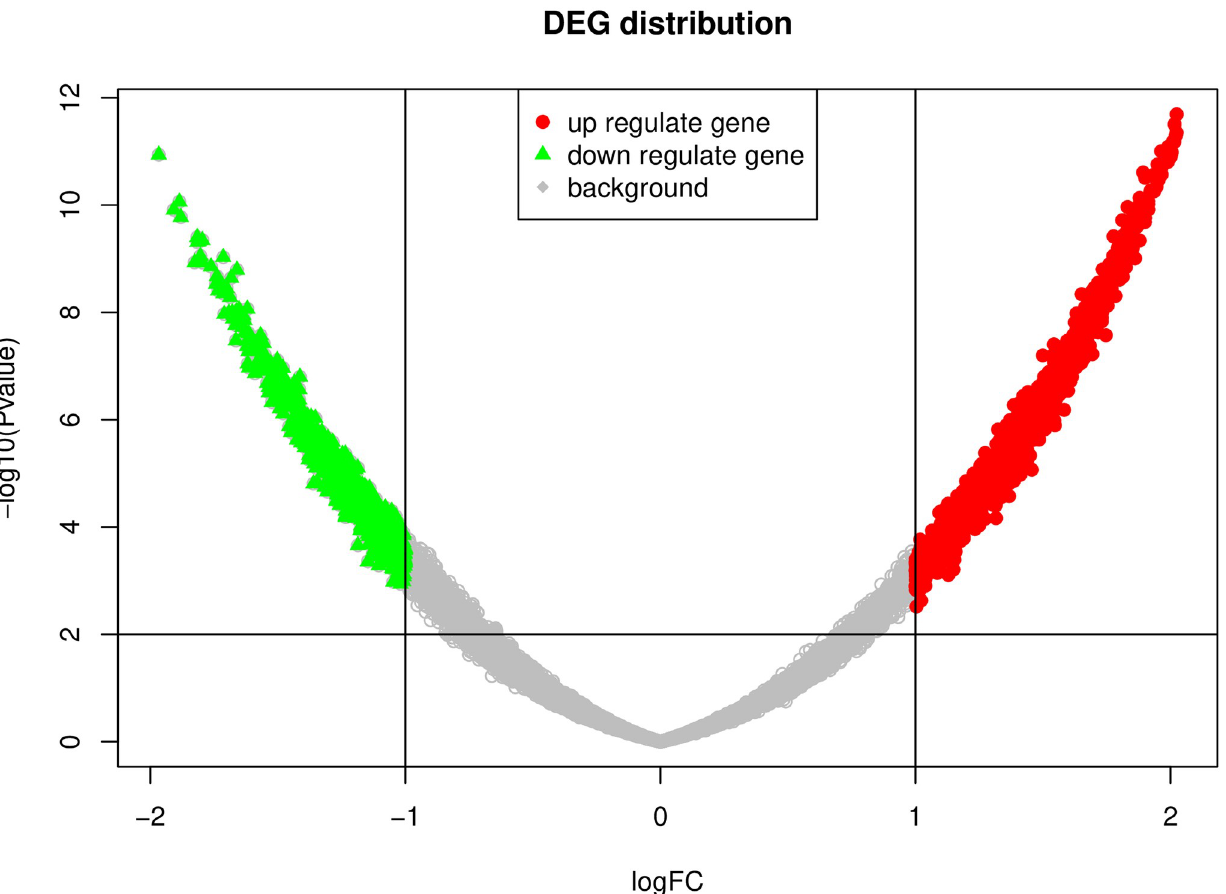
Fig 1. Volcano graph. The horizontal axis is logfc, and the vertical axis is the p-value of negative logarithmic transformation.